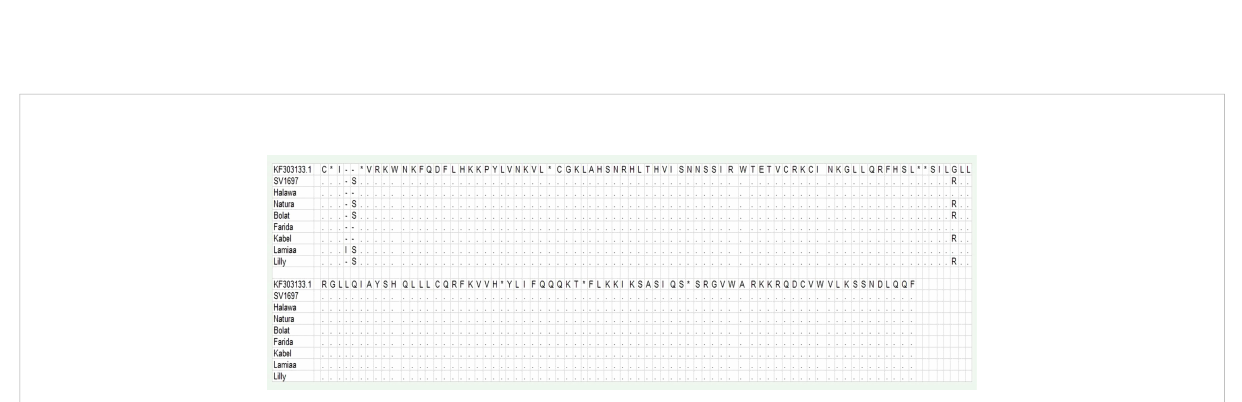
FIGURE 8 Alignment of the deduced amino acid sequences of eight obtained with MEGA-X software. Conserved consensus sequences are indicated by